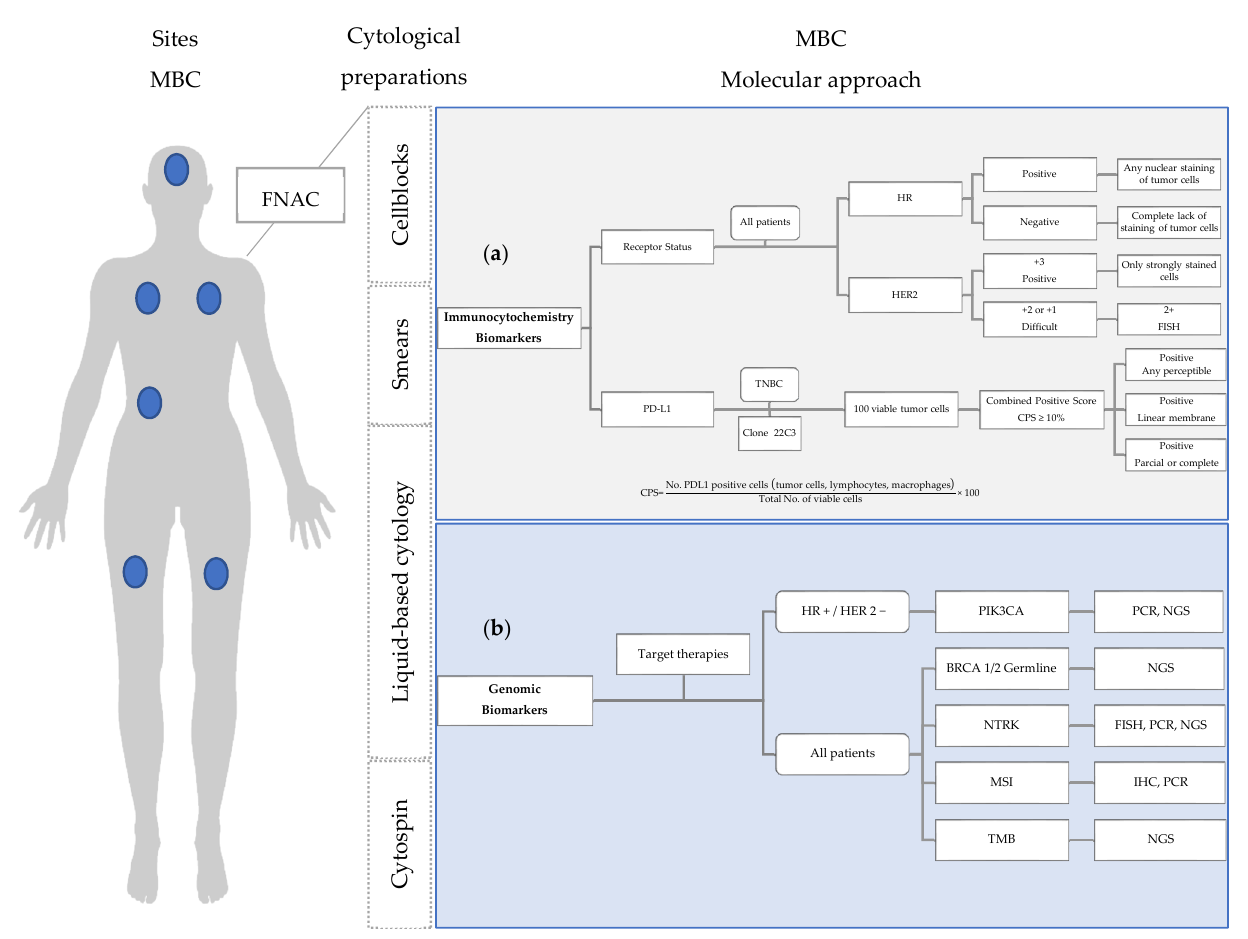
Figure 1. Molecular approach in the characterization of MBC hallmarks, using cytological preparations: ( a ) Immunocytochemistry biomarkers: Criteria for assessing HR and HER2 receptor status and PD-L1 expression in cytological material; ( b ) Genomic biomarkers: therapeutically relevant molecular changes in MBC and detection methods. FISH: fluorescence in situ hybridization; HR: hormone receptor; FNAC: fine needle aspiration cytology; MBC: metastatic breast cancer; NGS: next generation sequencing; PCR: polymerase chain reaction; TNBC: triple negative breast cancer.